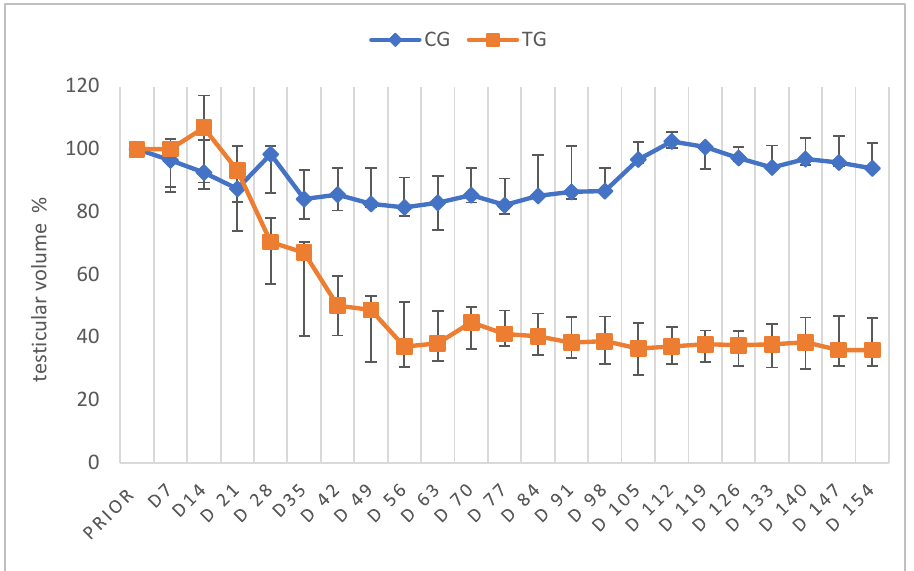
Figure 2. Testicular volume measured by a caliper given in % as median (Q1, Q3) over time; animals treated with a 4.7 mg deslorelin implant (TG, n = 7); saline-treated control animals (CG, n = 3). “Prior” indicates “prior to treatment”.